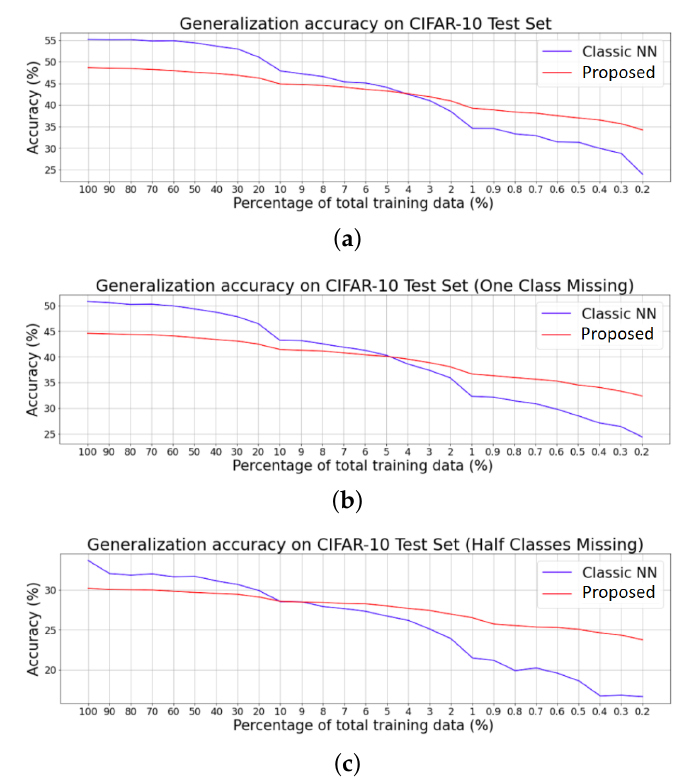
Figure 4. Results of our data scarcity experiments on the CIFAR dataset: ( a ) all classes present in training, ( b ) class ‘car’ missing from training, and ( c ) half of classes missing in